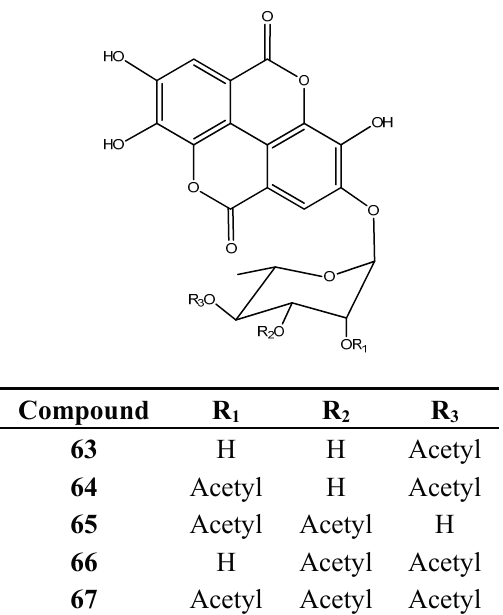
Figure 7. Tannins isolated from Myrcia species.